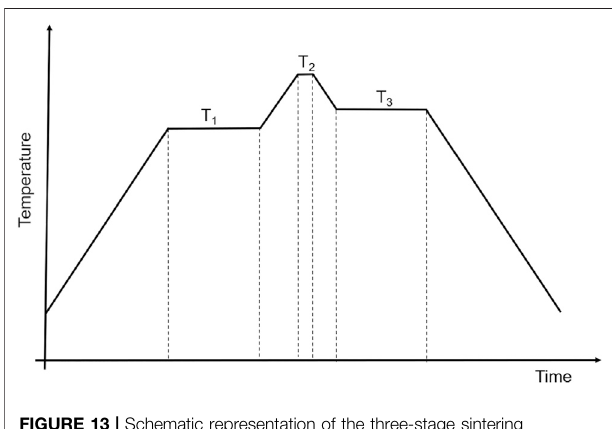
FIGURE 13 | Schematic representation of the three-stage sintering (3SS) approach for consolidation of Al 2 W 3 O 12 (Prisco et al., 2019).